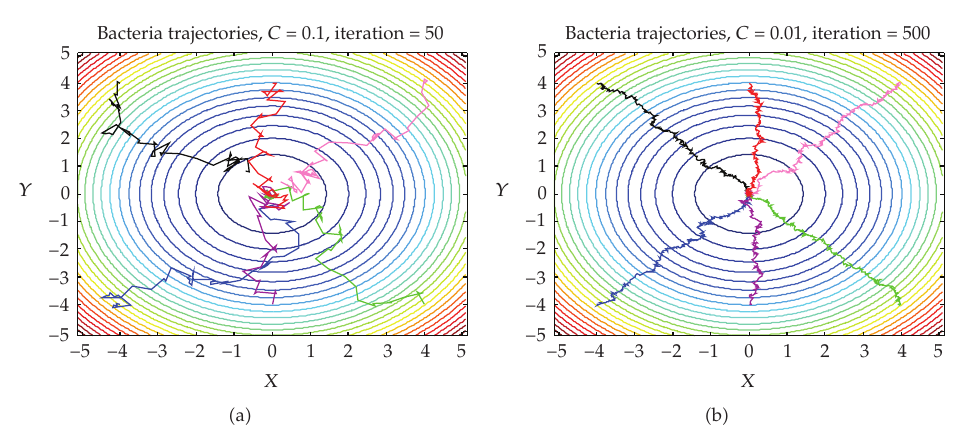
Figure 1: Bacterial Foraging trajectories on the 2D Sphere